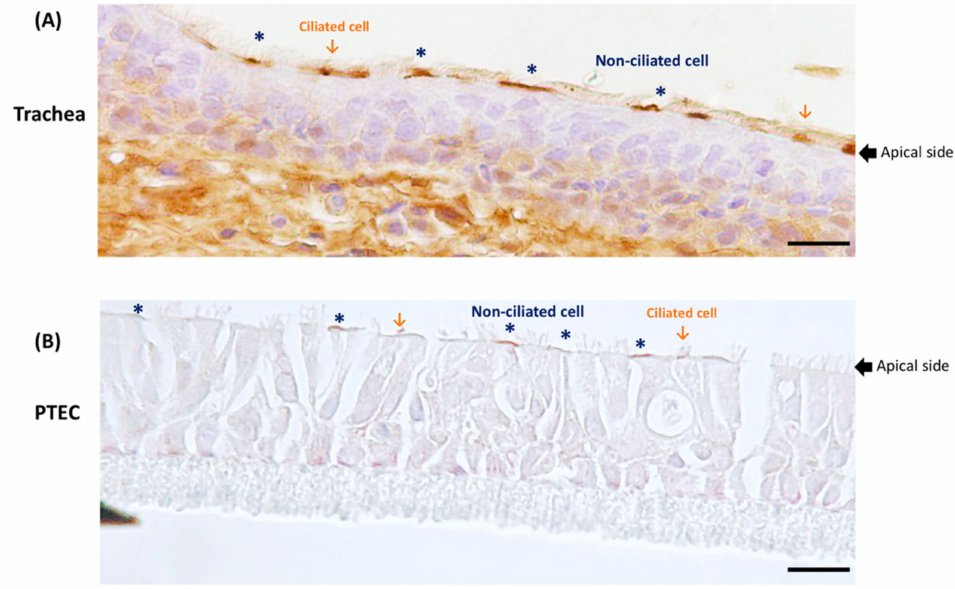
Figure 3. Expression of pAPN on the trachea ( A ) and well-di ff erentiated porcine tracheal epithelial cells (wdPTECs) ( B ) by immunohistochemistry staining. ( A ) cell-selective expression of pAPN in porcine tracheal tissue; ( B ) the expression of pAPN location on wdPTECs; The presence of pAPN antigen (brown staining) detected on the apical side can be shown on both the non-ciliated of pseudostratified epithelial cells (asterisk) and the ciliated of pseudostratified epithelial cells (arrow). Scale bar = 20 µ